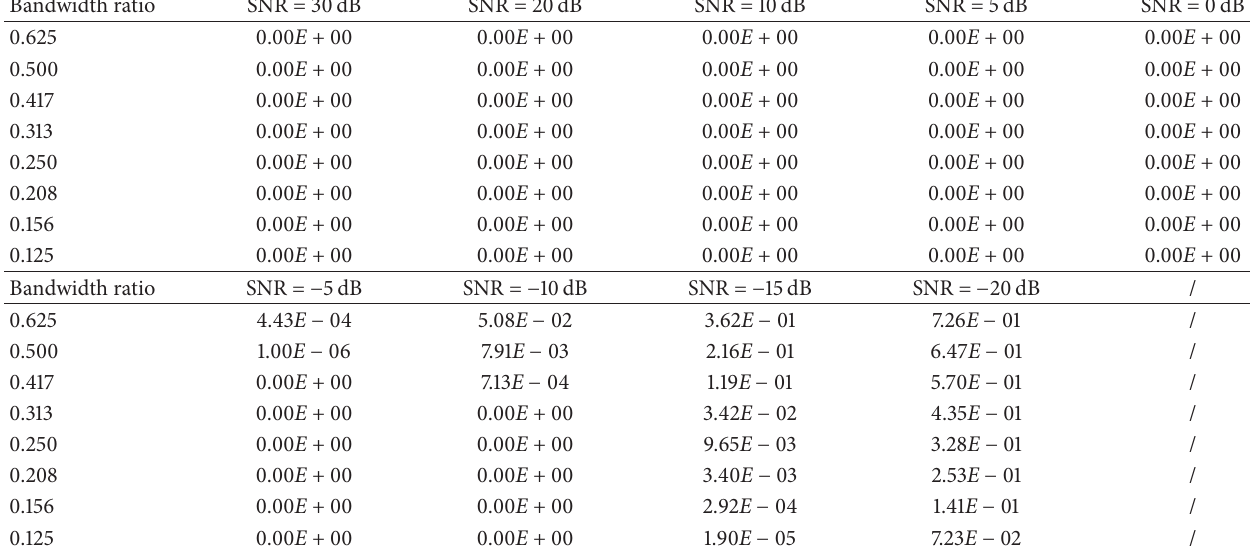
Table 2: The BER of the